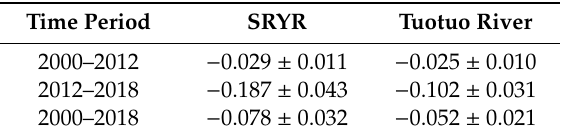
Table 4. Glacier mass balances (Gt yr − 1 ) of the GLDDM in the source region of the Yangtze River(SRYR), and the catchment of the Tuotuo